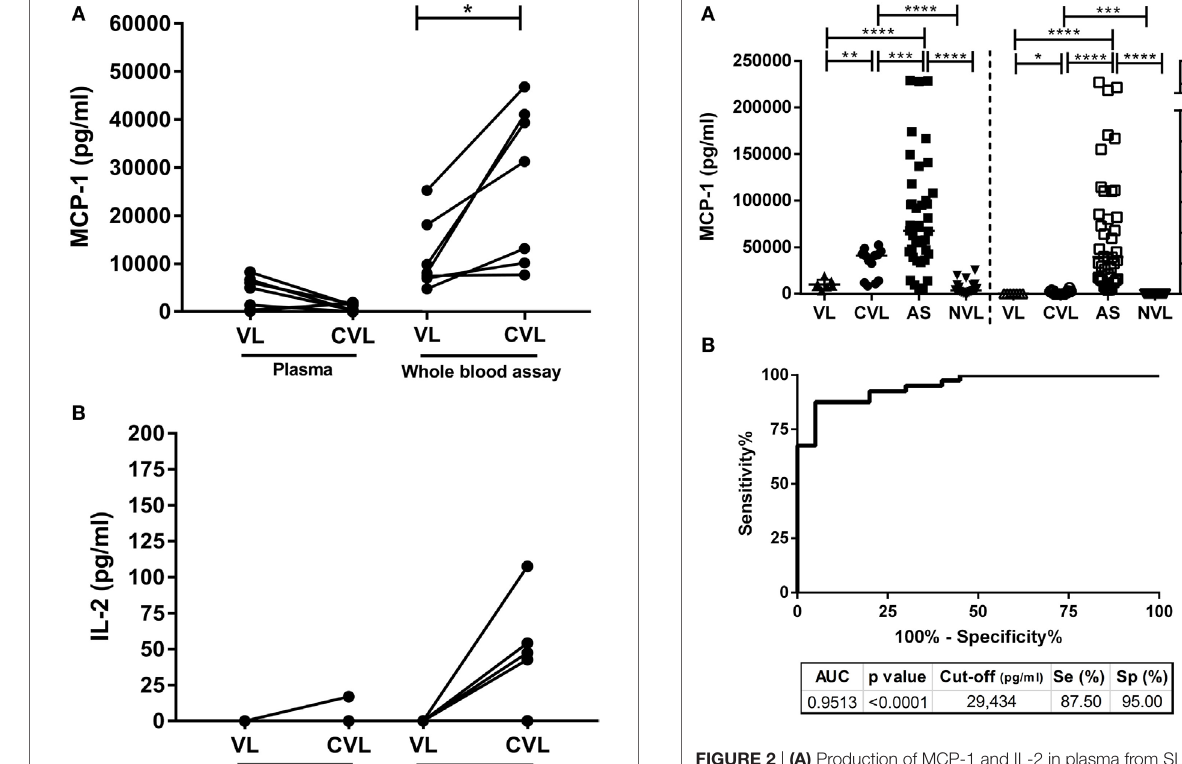
FiGUre 2 | (A) Production of MCP-1 and IL-2 in plasma from SLA- stimulated whole blood taken from active visceral leishmaniasis (VL, n = 7), cured visceral leishmaniasis (CVL; n = 14), asymptomatic participants (AS; n = 40) and negative controls (NVL; n = 20). Horizontal bars represent median concentrations. Each dot represents one subject. Data were analyzed using the Mann–Whitney U test. * p < 0.05; ** p < 0.01; *** p < 0.001; **** p < 0.0001. (B) Receiver operating characteristic (ROC) curve showing the sensitivity and specificity of monocyte chemotactic protein 1 (MCP-1) in the detection of asymptomatic individuals. The AUC of MCP-1, p -value, cut-off, sensitivity, and specificity are indicated on the